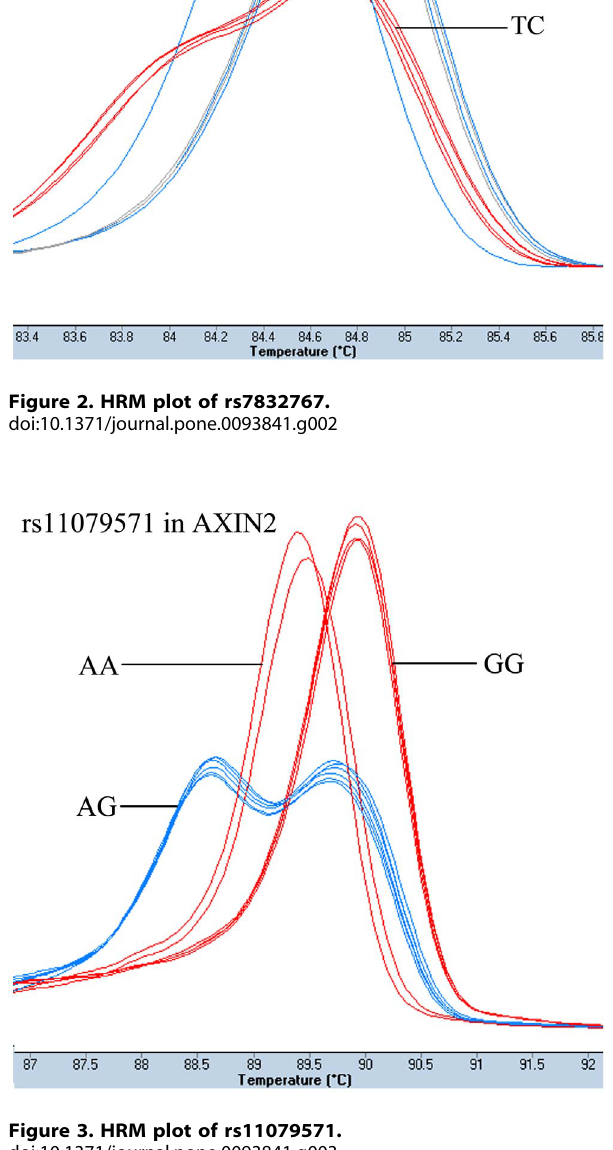
Figure 3. HRM plot of rs11079571.